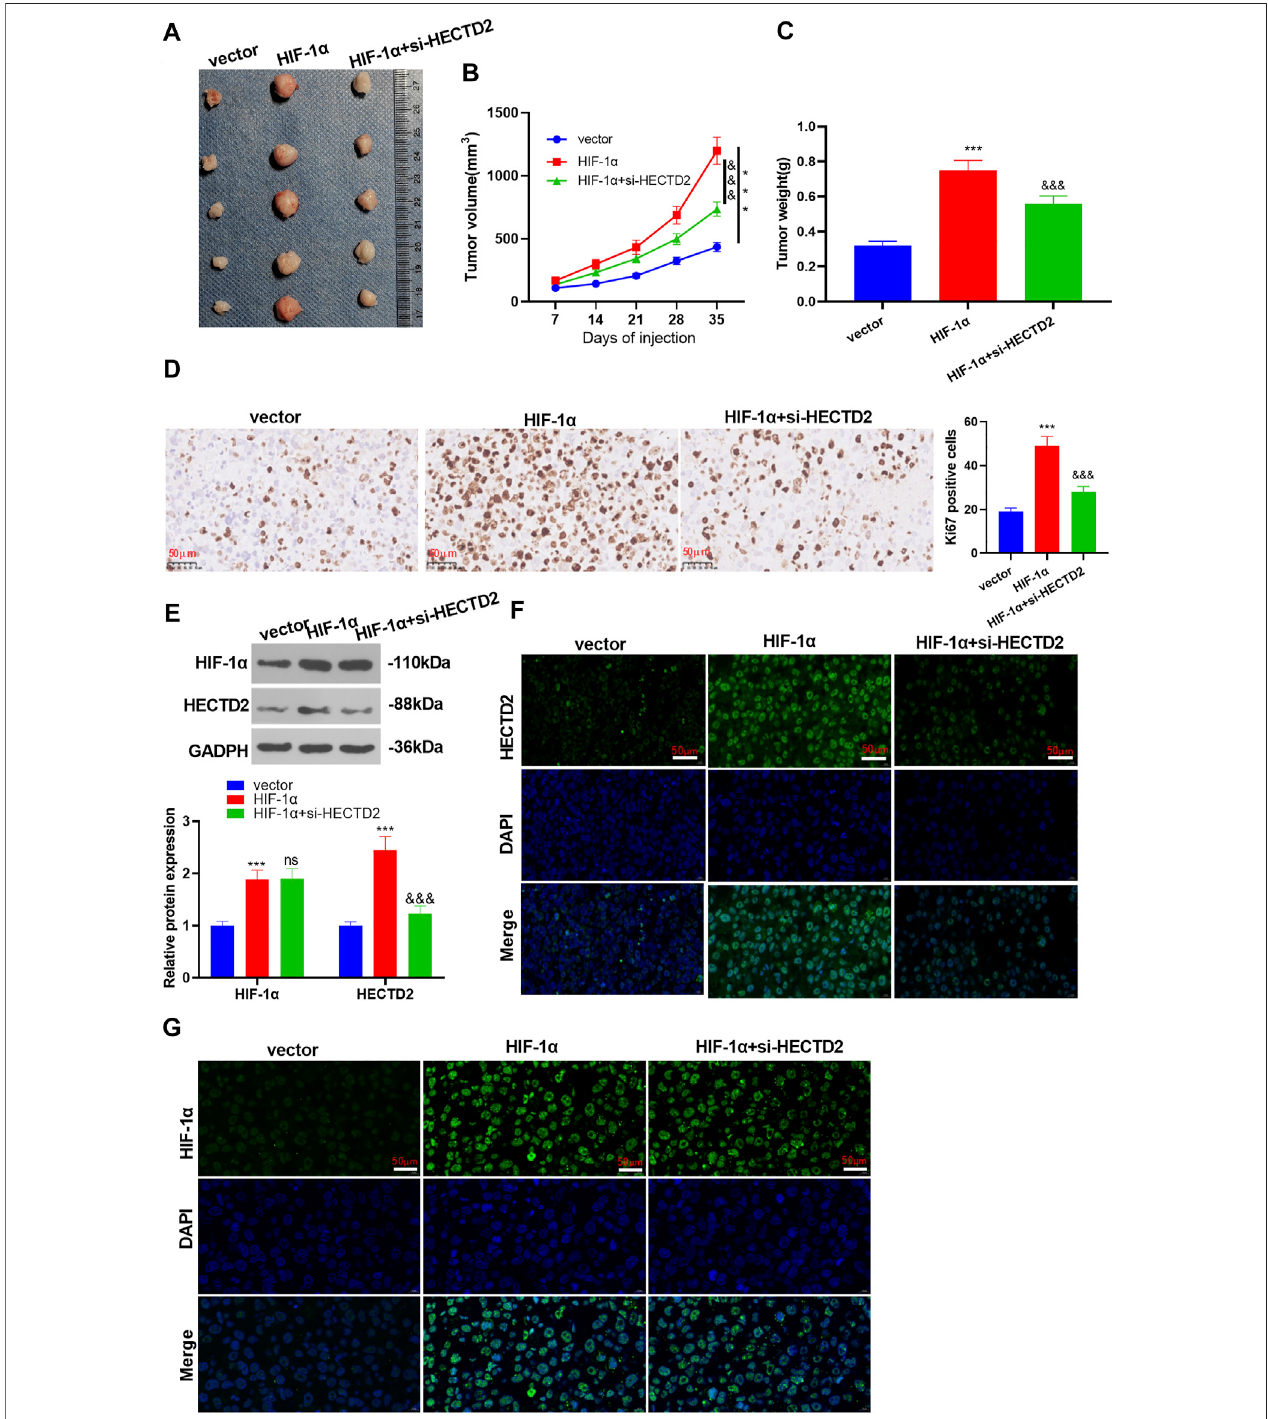
FIGURE 5 | Impacts of the HIF-1 α /HECTD2 axis on RCC cell growth in vivo. HIF-1 α overexpression and/or HECTD2 knockdown cell model was used for constructing xenografted tumor model in nude mice. The mice were sacri fi ced at the 35th day after cell transplantation. (A – C) : Tumor volume and weight. (D) : IHC was adopted to count the number of Ki67-positive cells in 786-O and A-498. (E) : The pro fi les of HIF-1 α and HECTD2 in 786-O and HECTD2 cells were monitored by WB. (F,G) :The fl uorescence intensityofHIF-1 α andHECTD2 wascheckedbytissue immuno fl uorescence.ns p > 0.05,* p < 0.05,** p < 0.01,*** p < 0.001. N (cid:2) 5.Scale bar (cid:2) 50 μ m.